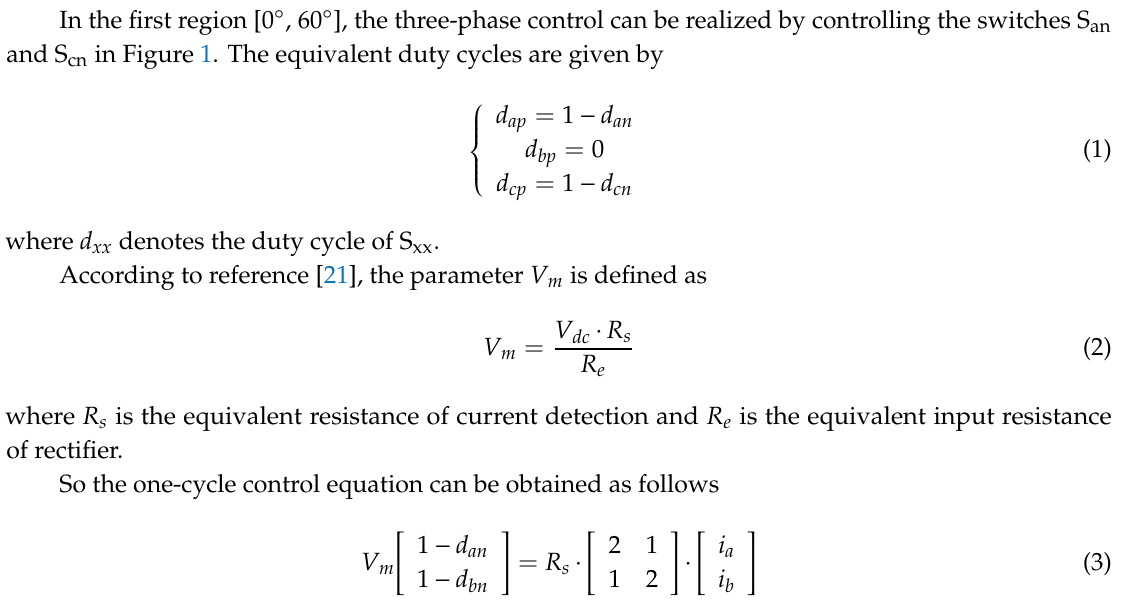
Figure 2. Voltage partitioning principle in three-phase balance power system.